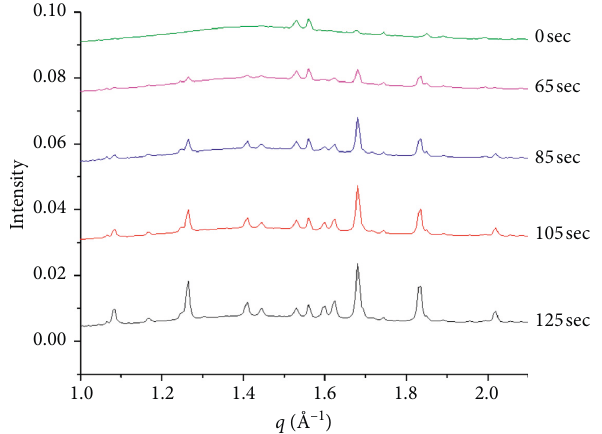
Figure 8: WAXS patterns of 5% AOT/APAP on the CS film at different time points.